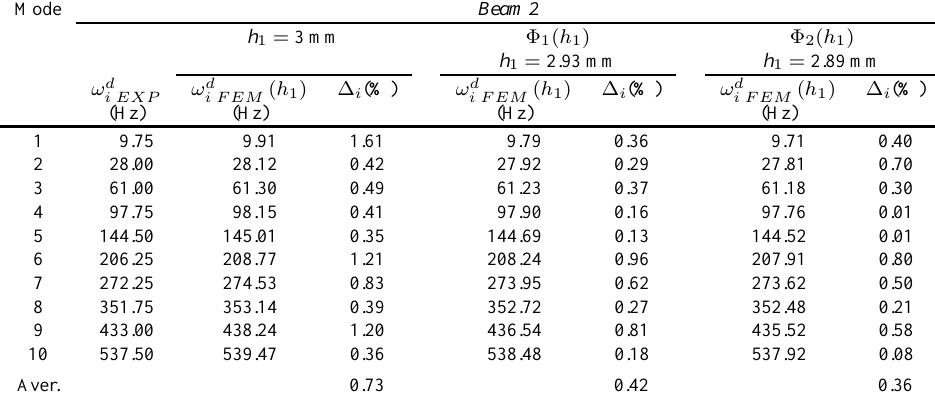
Table 3 Flexural frequencies and residuals for the Beam 2 calculated using identified damage